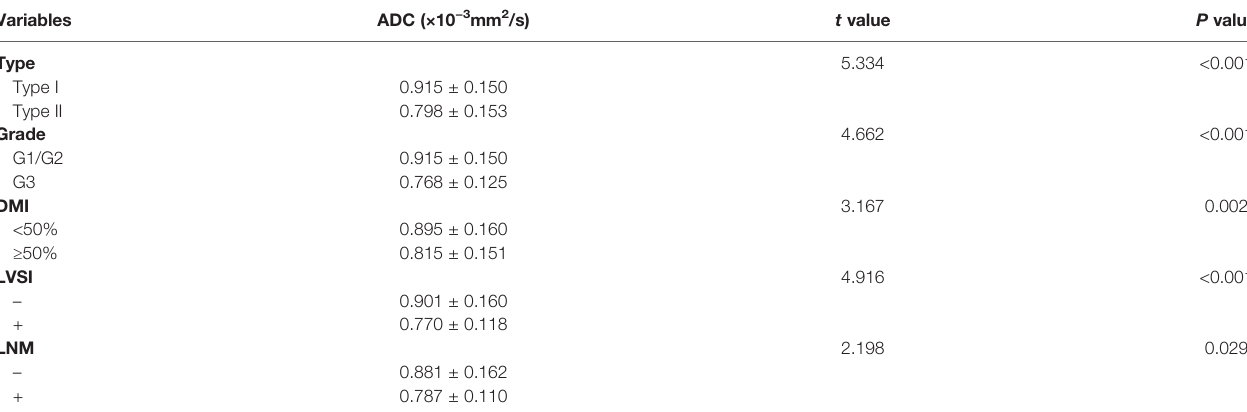
TABLE 2 | The ADC value in relation to clinical and histologic